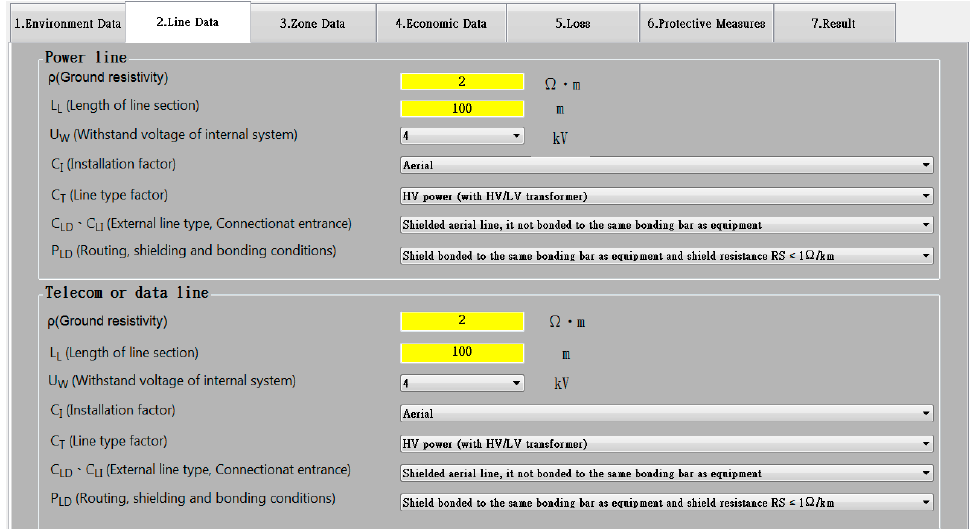
Figure 5. The line data.